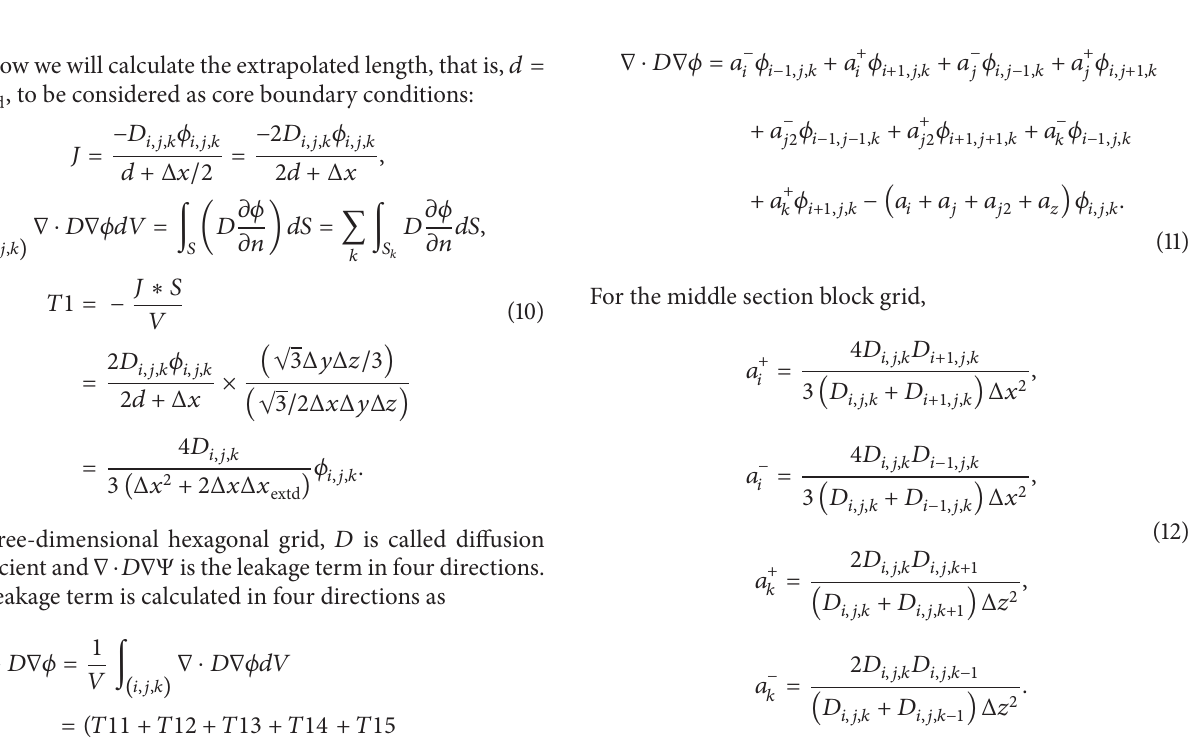
Figure 2: Flow diagram of REMARK code with